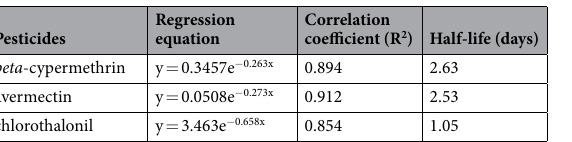
Table 3. Regression equation, correlation coefficient and half-lives of beta -cypermethrin, avermectin and chlorothalonil in soil.